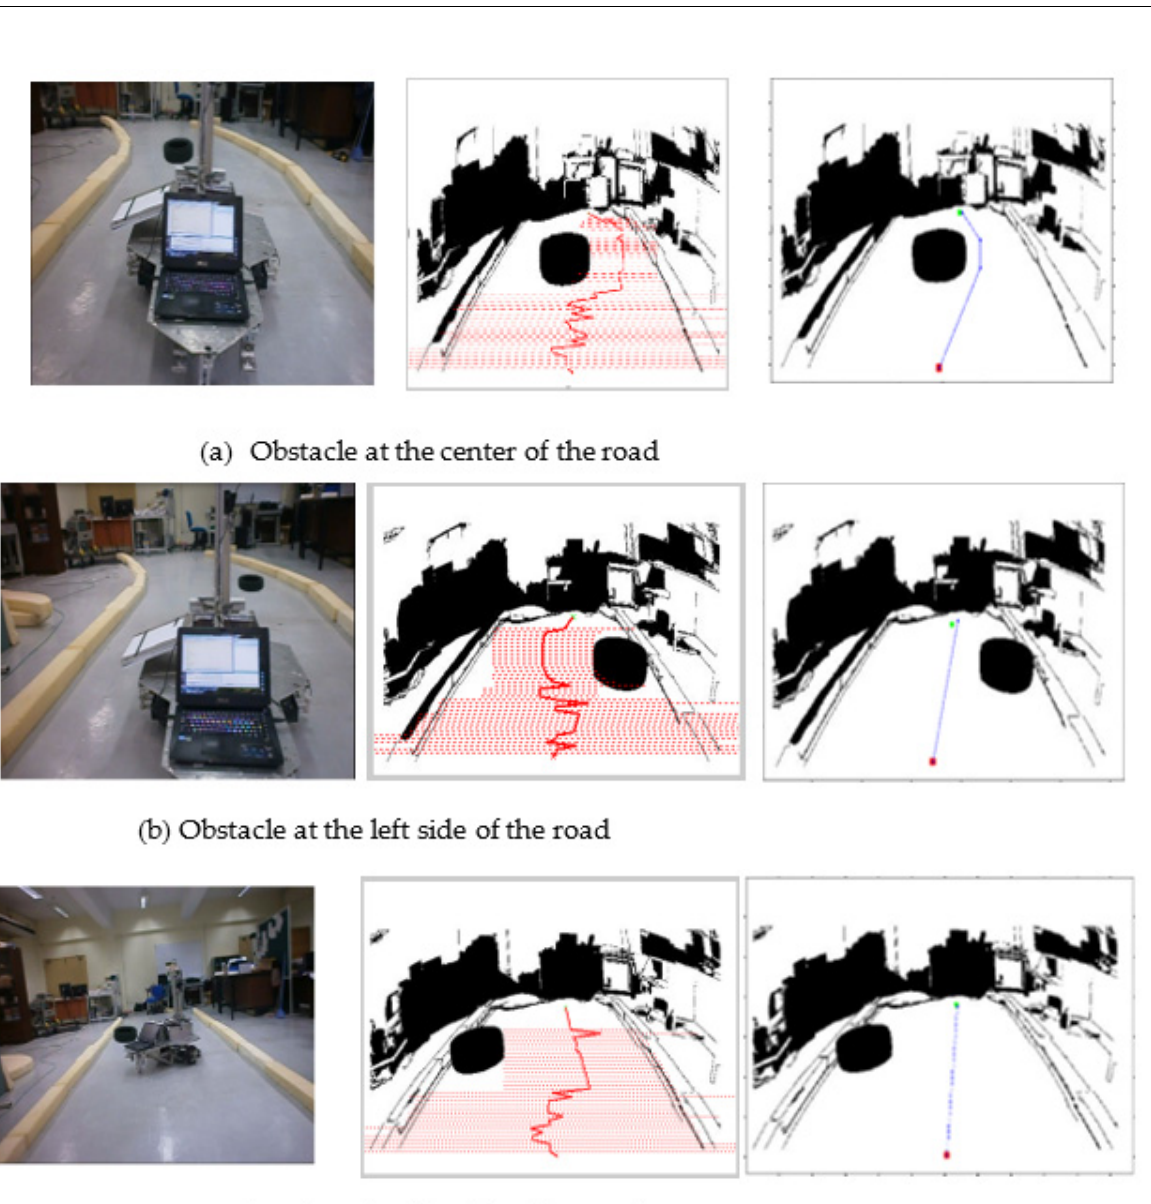
Figure 14. Indoor navigation with obstacle on the left side of the road. ( a ) Original image; ( b ) applying LS algorithm; ( c ) applying GLS algorithm.